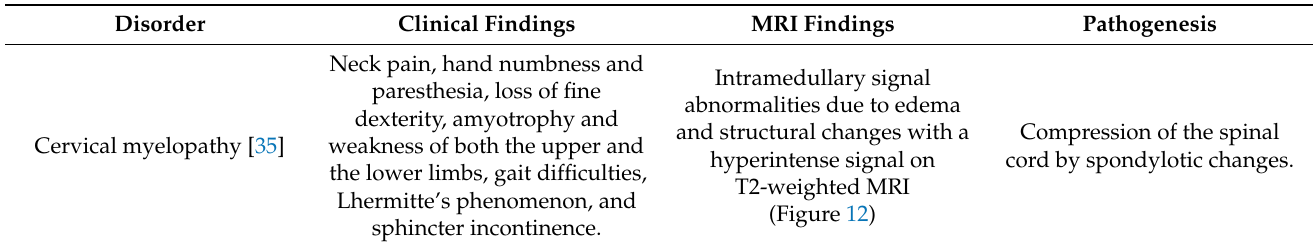
Table 2. Differential diagnosis of syringomyelia-associated amyotrophic lateral sclerosis mimic syndrome in the patient with Chiari malformation type